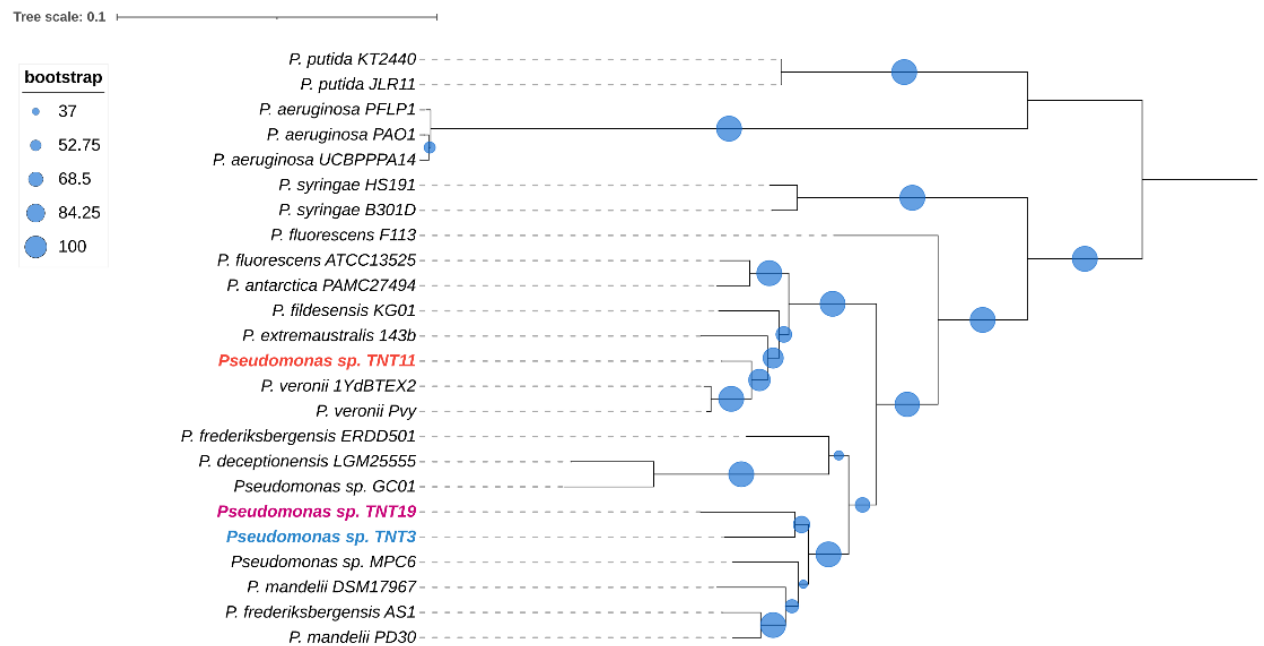
Figure 2. Maximum likelihood phylogenetic tree based on concatenated core gene sequences from the 24 pseudomonads considered in this study. The tree was generated with RAxML using the GTRGAMMA model. The size of the blue circles represents the percentage of bootstrap support for each branch (based on 100 iterations). The tree was midpoint rooted.